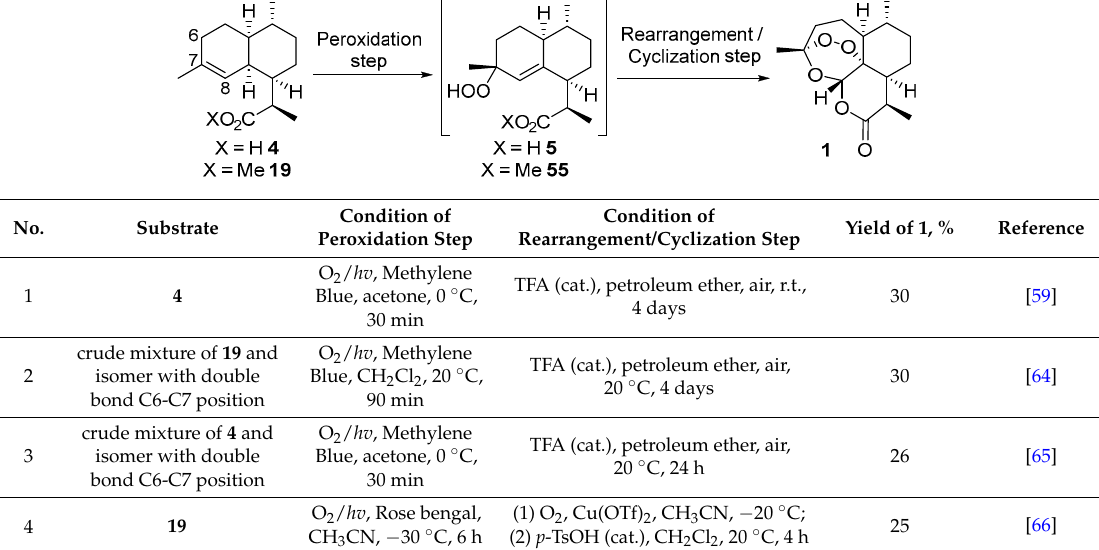
Table 1. In situ transformation of dihydroartemisinic acid ( 4 ) or its ester 19 into artemisinin ( 1 No. No.